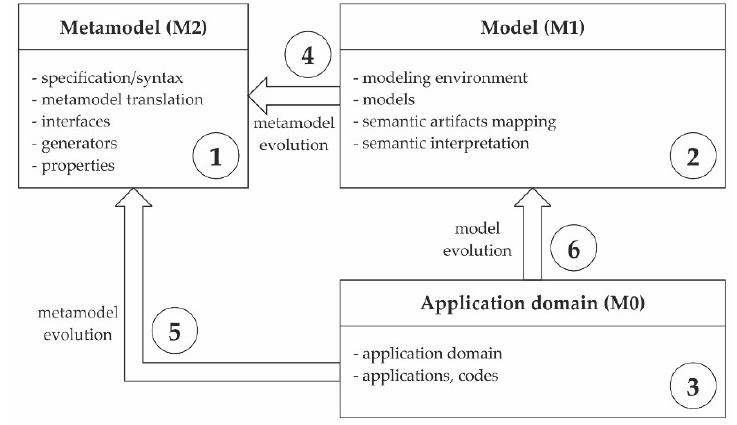
Figure 9. Metamodeling design process. (1) metamodeling tools; (2) modelling tools; (3) solution, that is, control system code; (4,5) evolution of metamodel; (6) evolution of model.